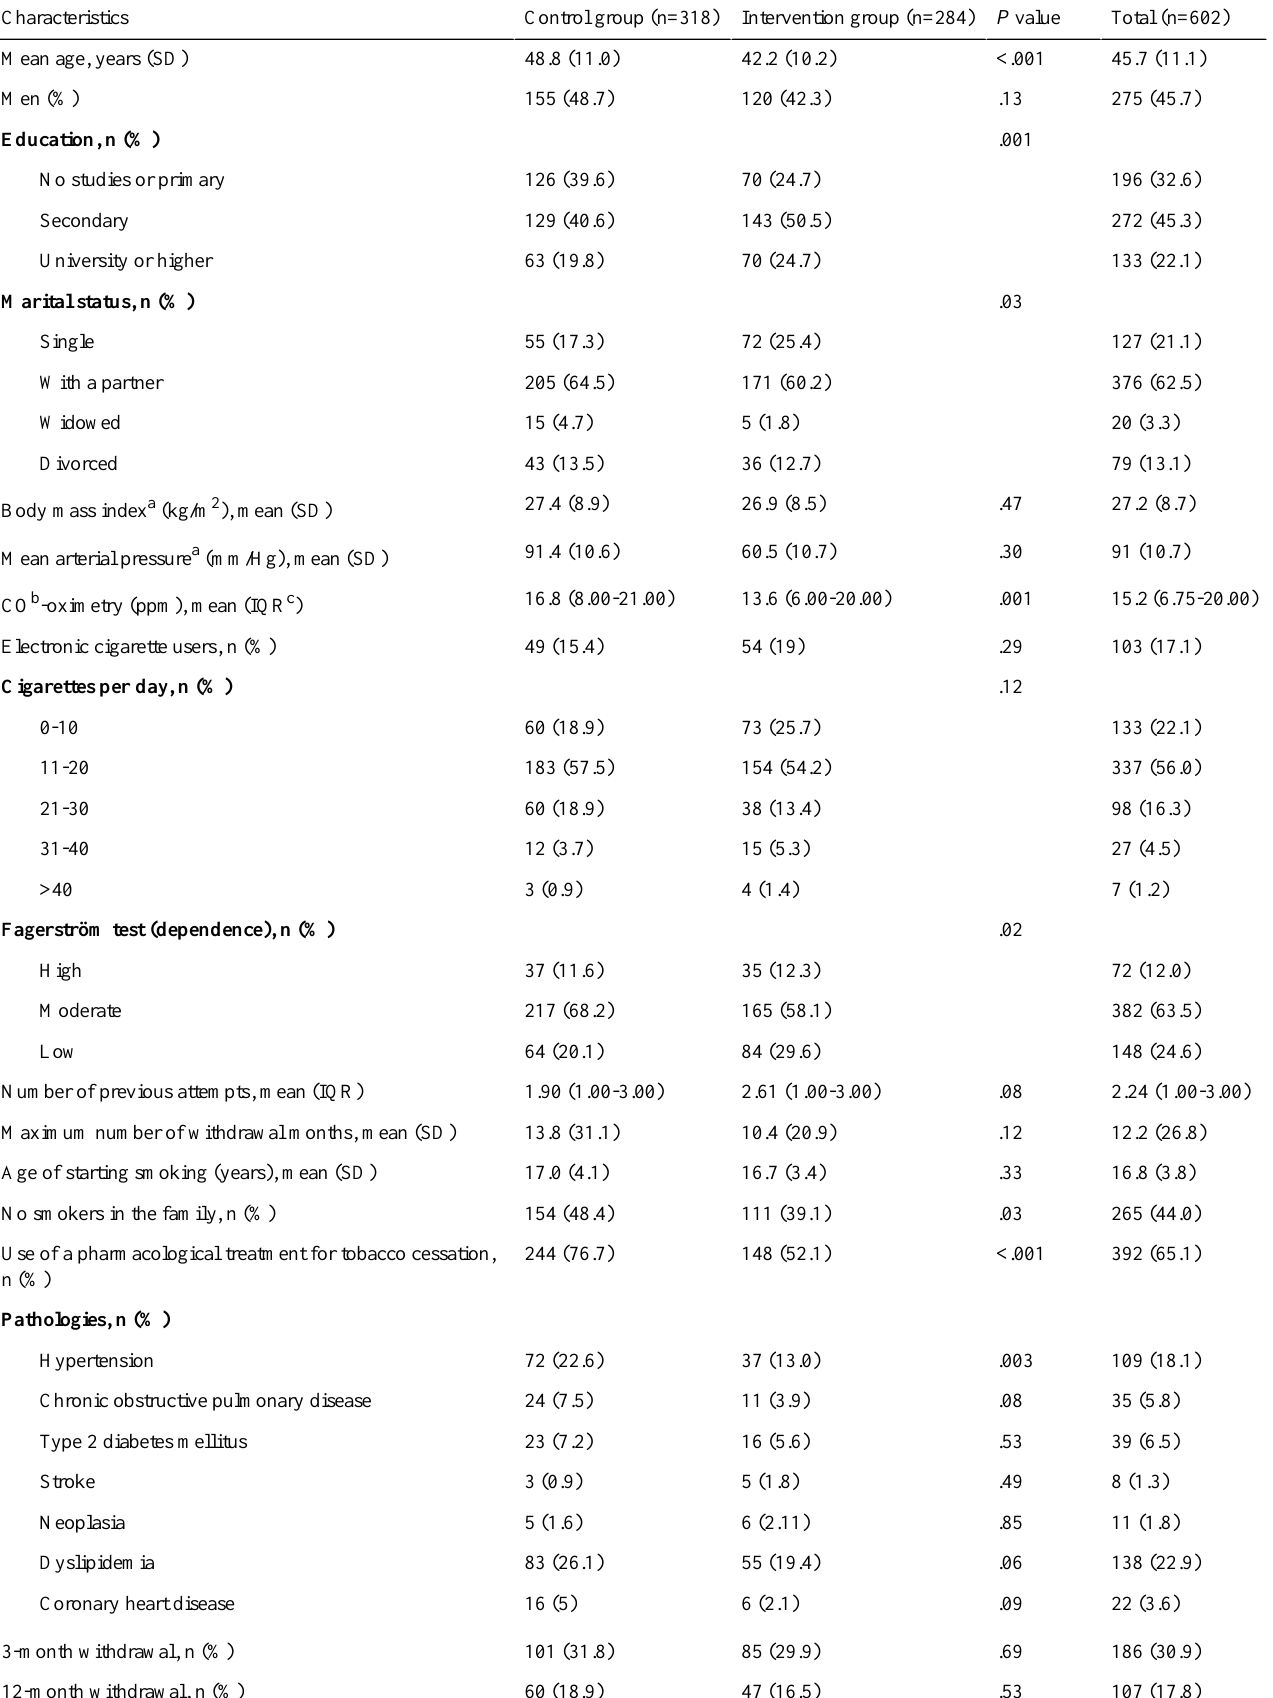
Table 1. Basic characteristics of the Tobbstop study participants based on their assigned